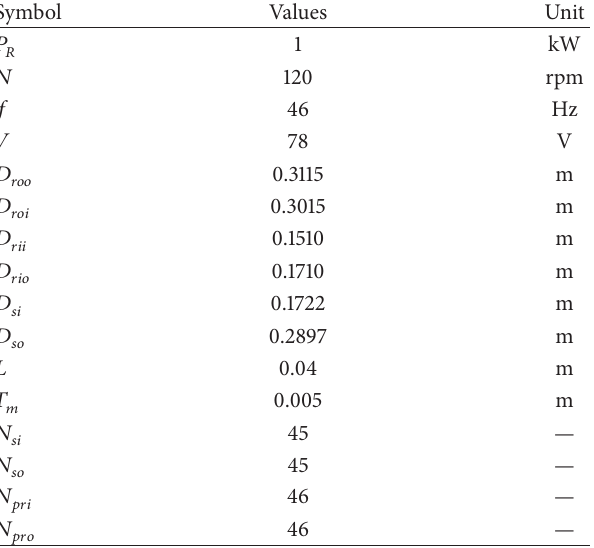
Table 4: Important specifications of DRFPMG prototype.